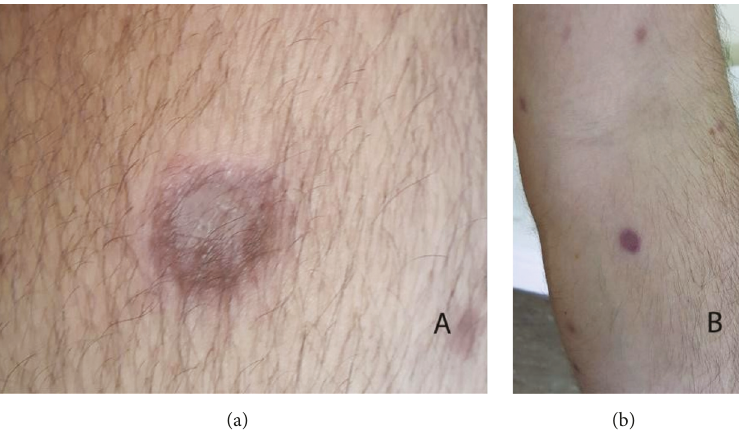
Figure 4: Complete remission of the eruption leaving depressed scars, including the previous tumor on the left thigh (a) and the papulonodular eruption at other body sites